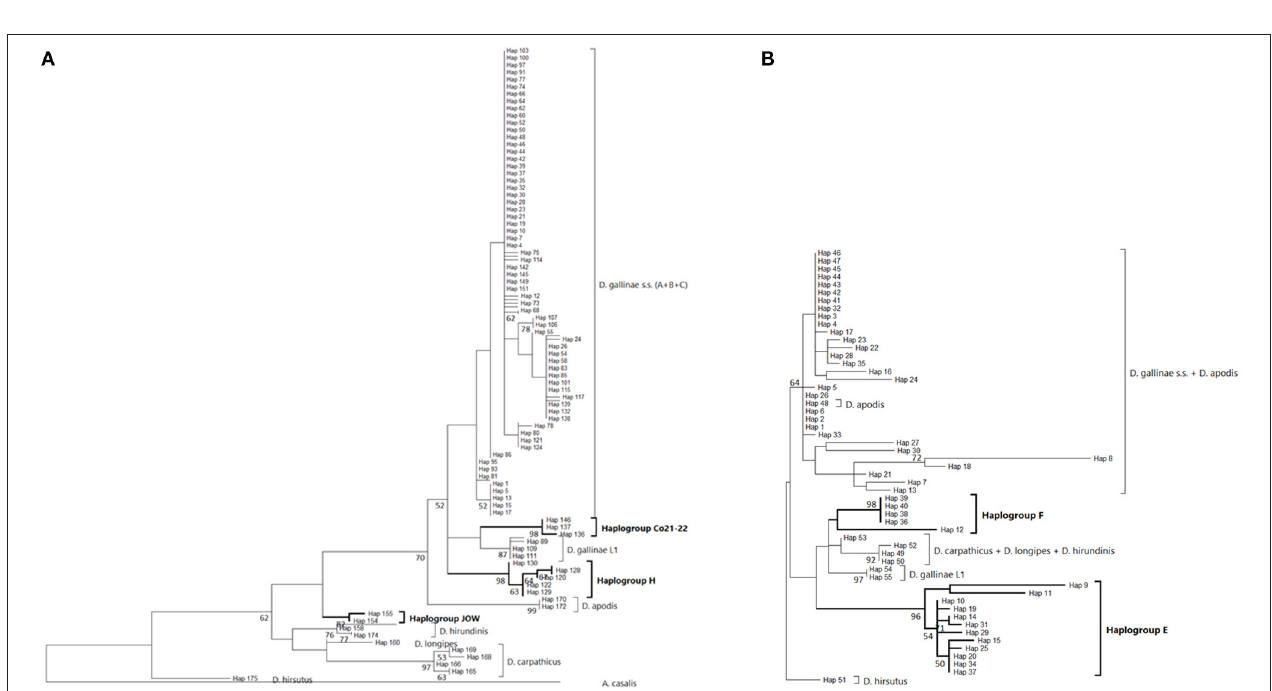
FIGURE 4 | D. hirundinis , D. longipes , D. hirsutus ). A single copy of each haplotype (55 nucleotide sequences) has been integrated to the analysis. The tree with the highest log likelihood ( − 2975.33) is shown. Only bootstrap values > 50% are displayed at the nodes. In order to be able to root the tree with outgroups and to obtain a sufficiently informative topology, we have integrated sequences that are not completely overlapping into the analysis (2, 3, 20, 24), new data). The non-overlapping areas have been supplemented by N in the alignment. (B) Haplotype network (MSN) from CO1 region-2 data. In order to work on haplotypes of reasonable size that are completely resolved in this genomic region with some representation of the population structure, we have integrated into the analysis exclusively the data from (20, 24) (Turkey) and the present data obtained for region 2 (four populations; France). Dashed lines delineate the only typical haplogroups of D. gallinae s.s. recorded from region 2 data (the colors correspond to those of the condensed clades in (A) ). The two atypical haplogroups in this dataset are indicated in italics. The size of the disks is proportional to the number of sequences present in the database and the name of one haplotypes identified in (2) appears on the disk (‘Co1’). Black dots = mutations.